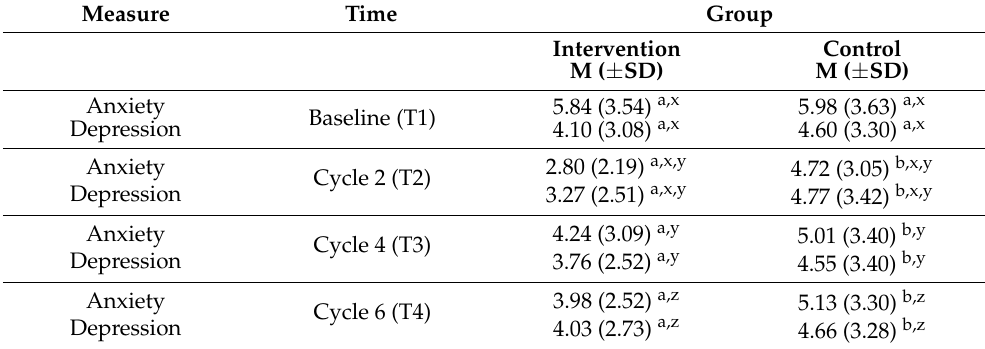
Table 3. Effect of SCEIP on HADS between and within intervention and control groups across